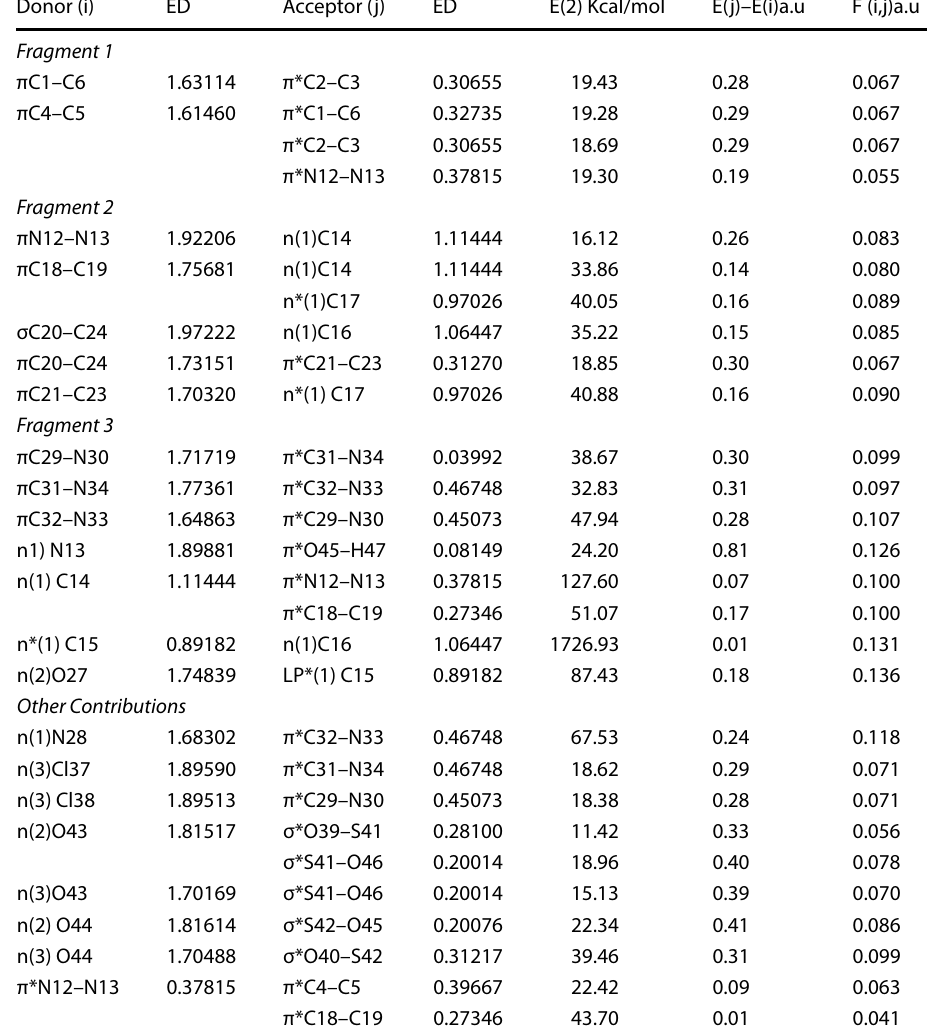
Table 4 Calculated second order perturbation energies from NBO analysis of cyanurated H-acid (CHA) using computed at the B3LYP/6- 31G(d,p)